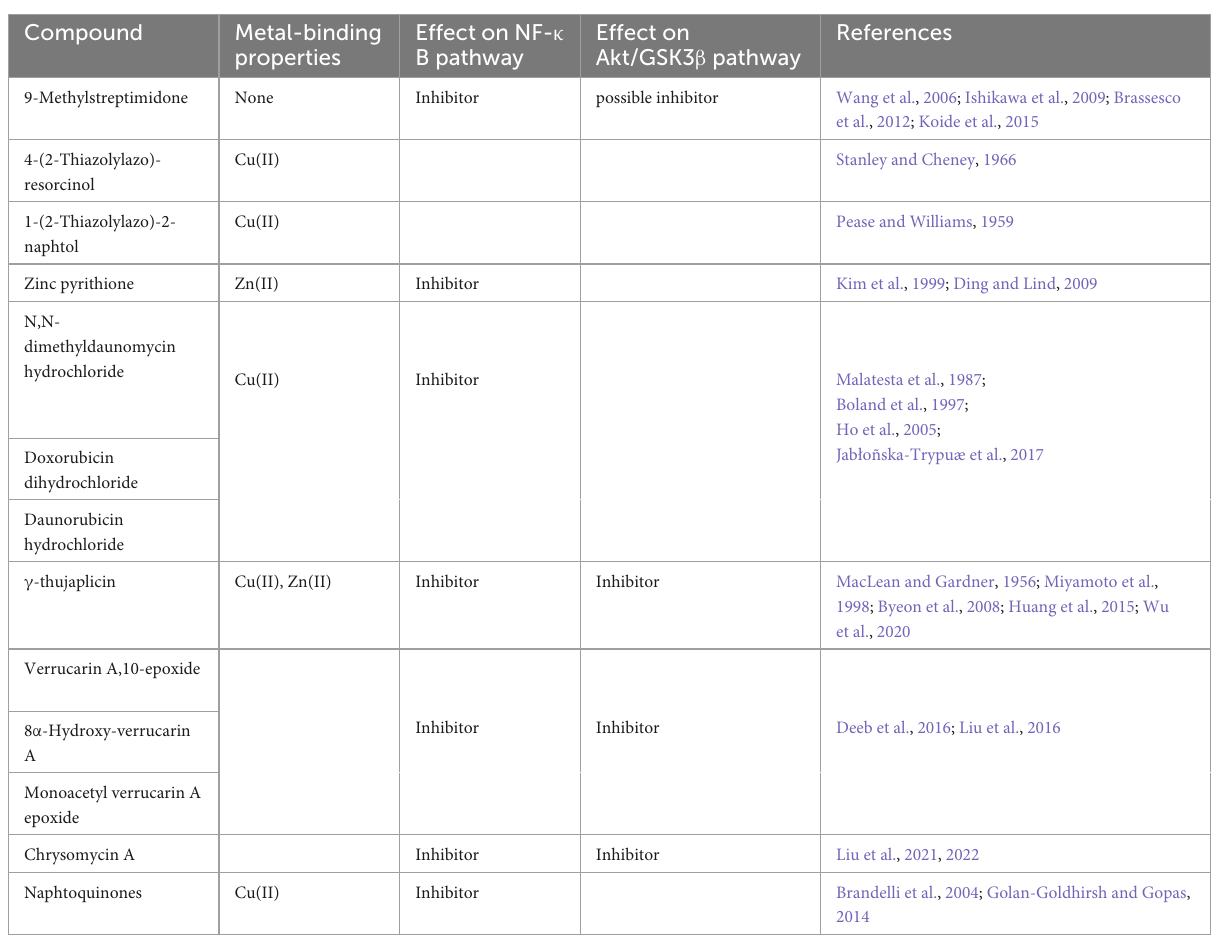
TABLE 1 The molecules identified in the screen share common properties such as metal cation binding or target pro-survival